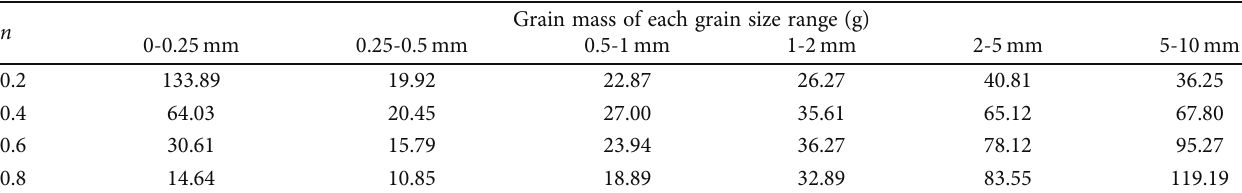
Figure 3: Screened samples with di ff erent grain sizes. Table 1: Grain quality under di ff erent n